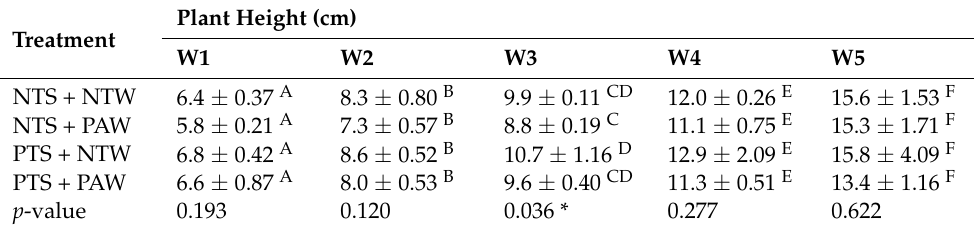
Table 2. The average height of water spinach grown under different treatments in control soil.